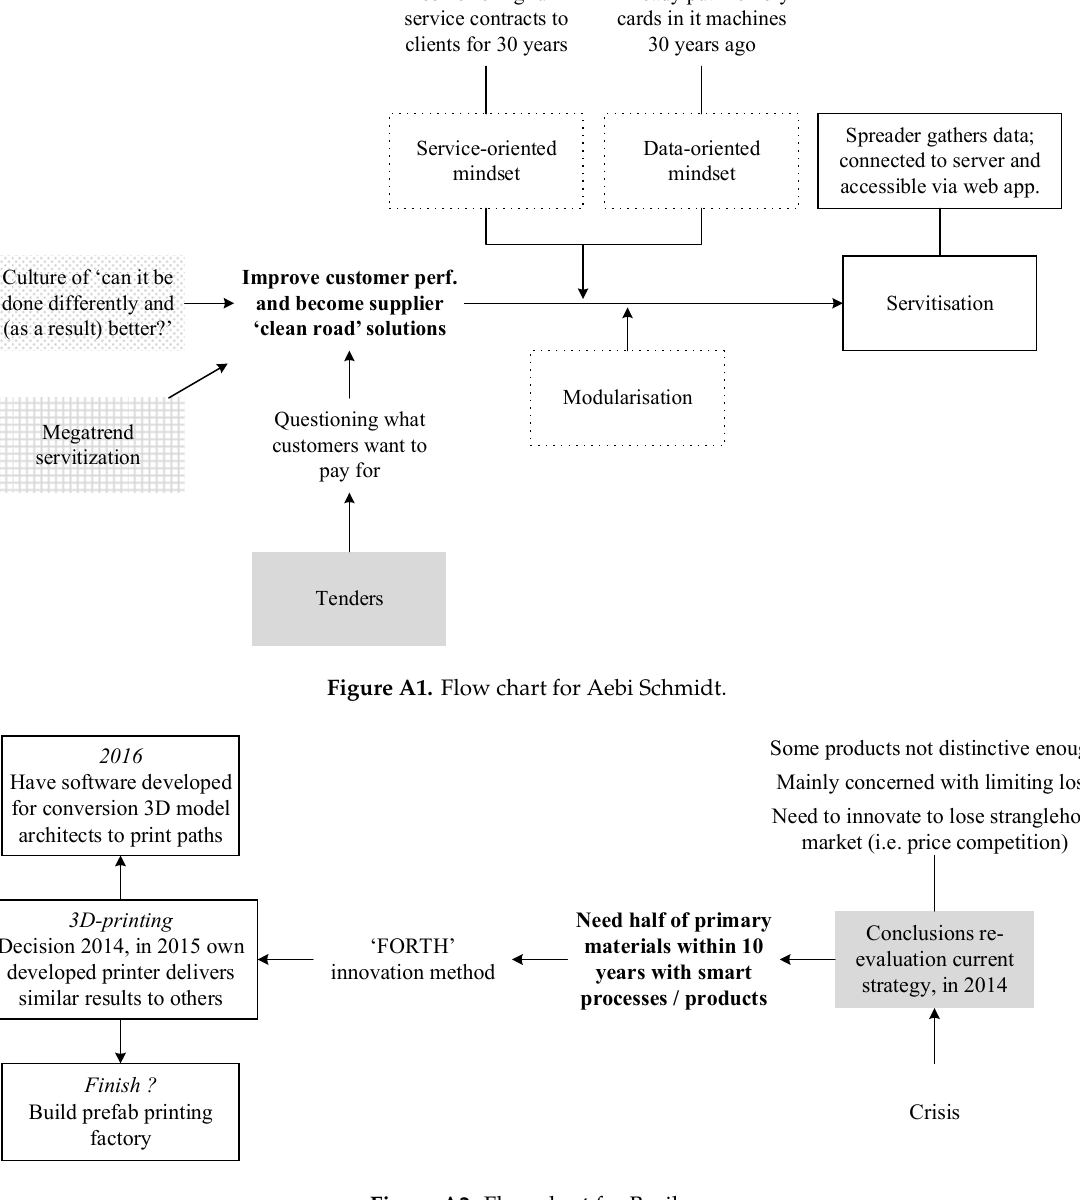
Figure A2. Flow chart for Bruil.